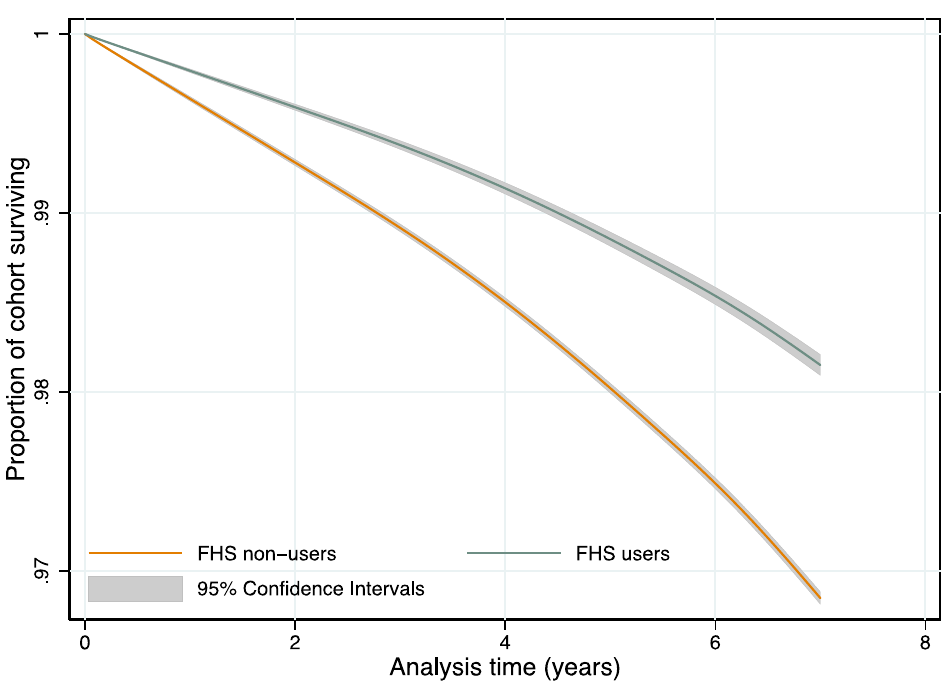
Fig 1. Adjusted survival function of cohort by FHS usage groups. Survival functions obtained from flexible parametric survival models with IPTW and regression adjustment for sex, race/ethnicity, age at cohort entry, highest level of education, disability, unemployment, household per capita income decile, number of family members per bedroom, family size, number of children in family, household flooring, household piped water access, quintiles of household expenditure on medicines, quintile of per capita household expenditure on food, formal labor employment, formal labor employment in the family, whether the family receives Bolsa Familia or not, and whether the individual has been hospitalized before FHS use. FHS, Family Health Strategy; IPTW, inverse probability treatment